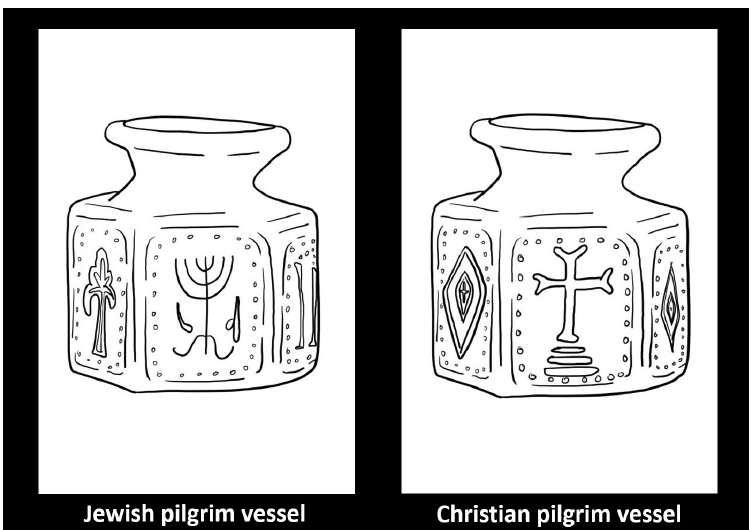
Figure 9. An illustration of Glass Jars with Menorah symbol and a symbol of the Cross which pointed to the possibility of the same manufacturer making the ‘Glass Jars’ and a potentially peaceful co-existence of both the religions at that point in time was added to include a new perspective in the